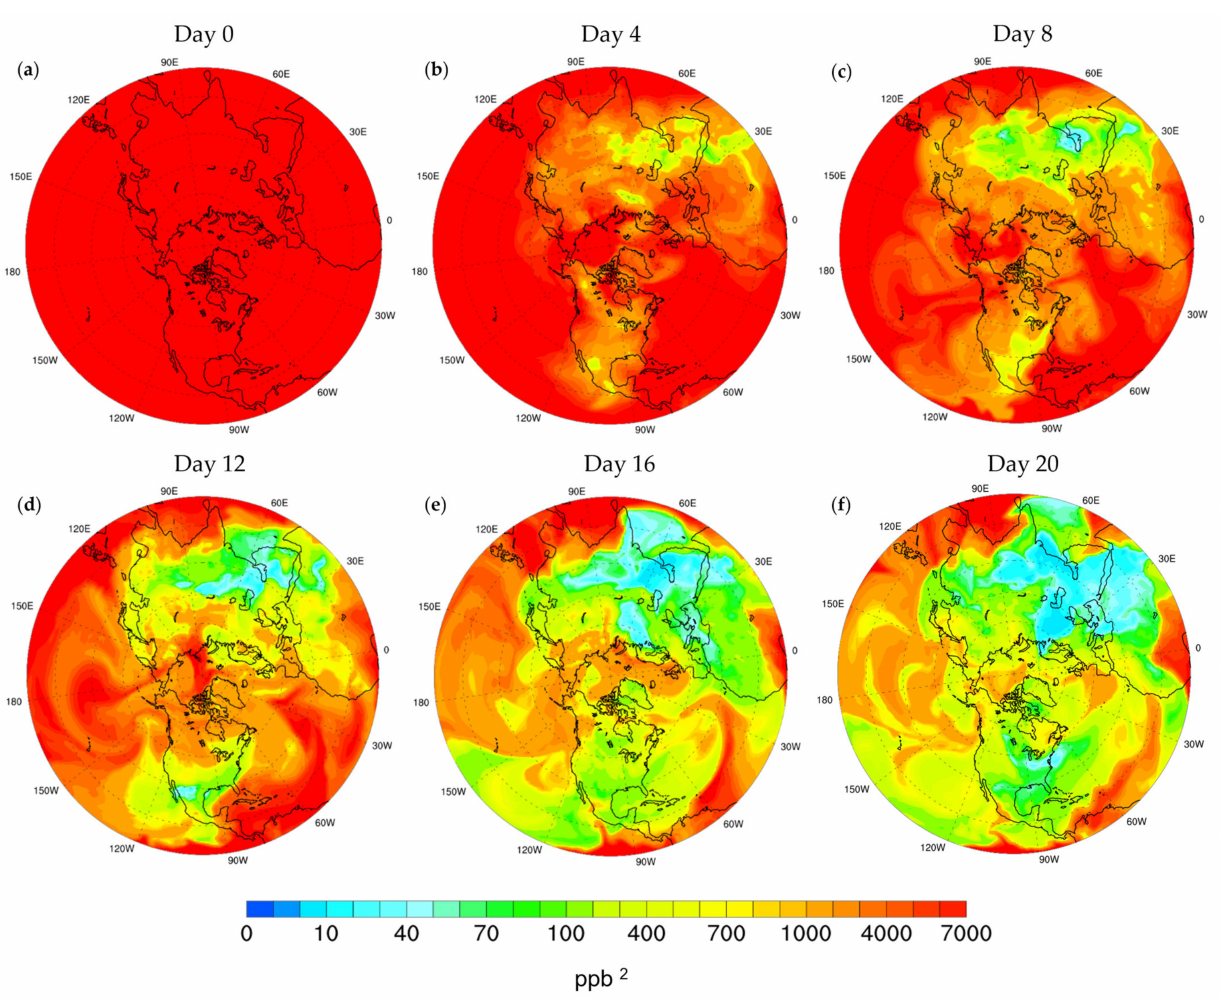
Figure 2. Evolution of the analysis error variance on ( a ) Day 0, ( b ) Day 4, ( c ) Day 8, ( d ) Day 12, ( e ) Day 16, and ( f ) Day